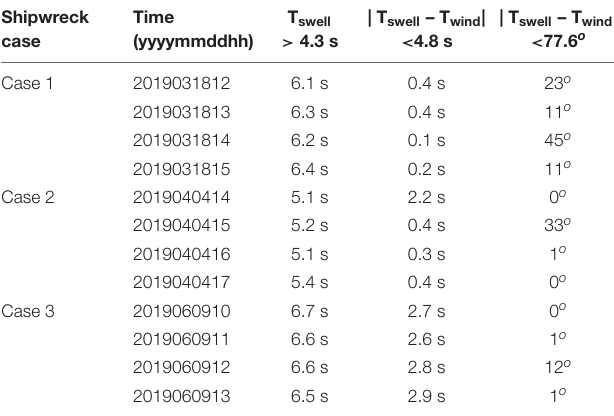
TABLE 2 | The verification of swell alert criteria with shipwrecks in 2019. Shipwreck